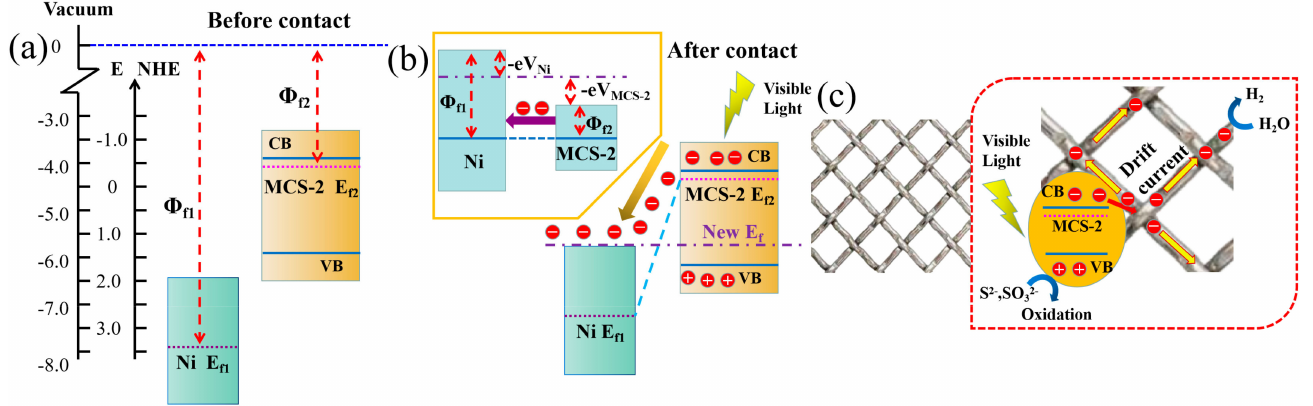
Figure 10. ( a ) The respective energy band structures of Ni and MCS-2 before contact are presented. ( b ) The Fermi energy level equilibrium process of Ni and MCS-2 after contact is proposed. ( c ) The photocatalytic mechanism of Ni/MCS-2 composites under visible light